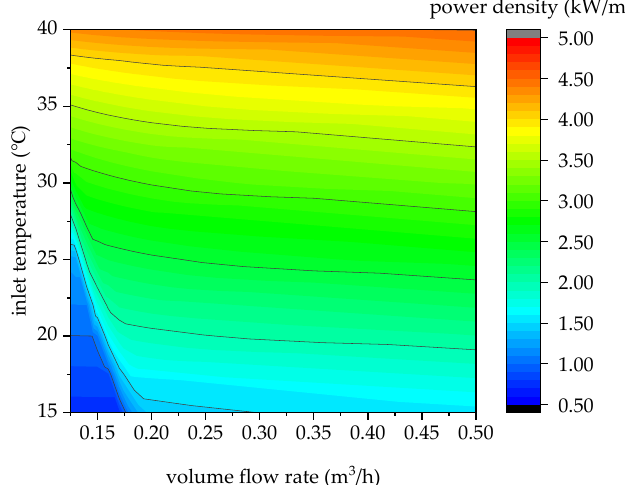
Figure 12. Heat exchange power density with different inlet temperature and. Volume flow rate of coolant.